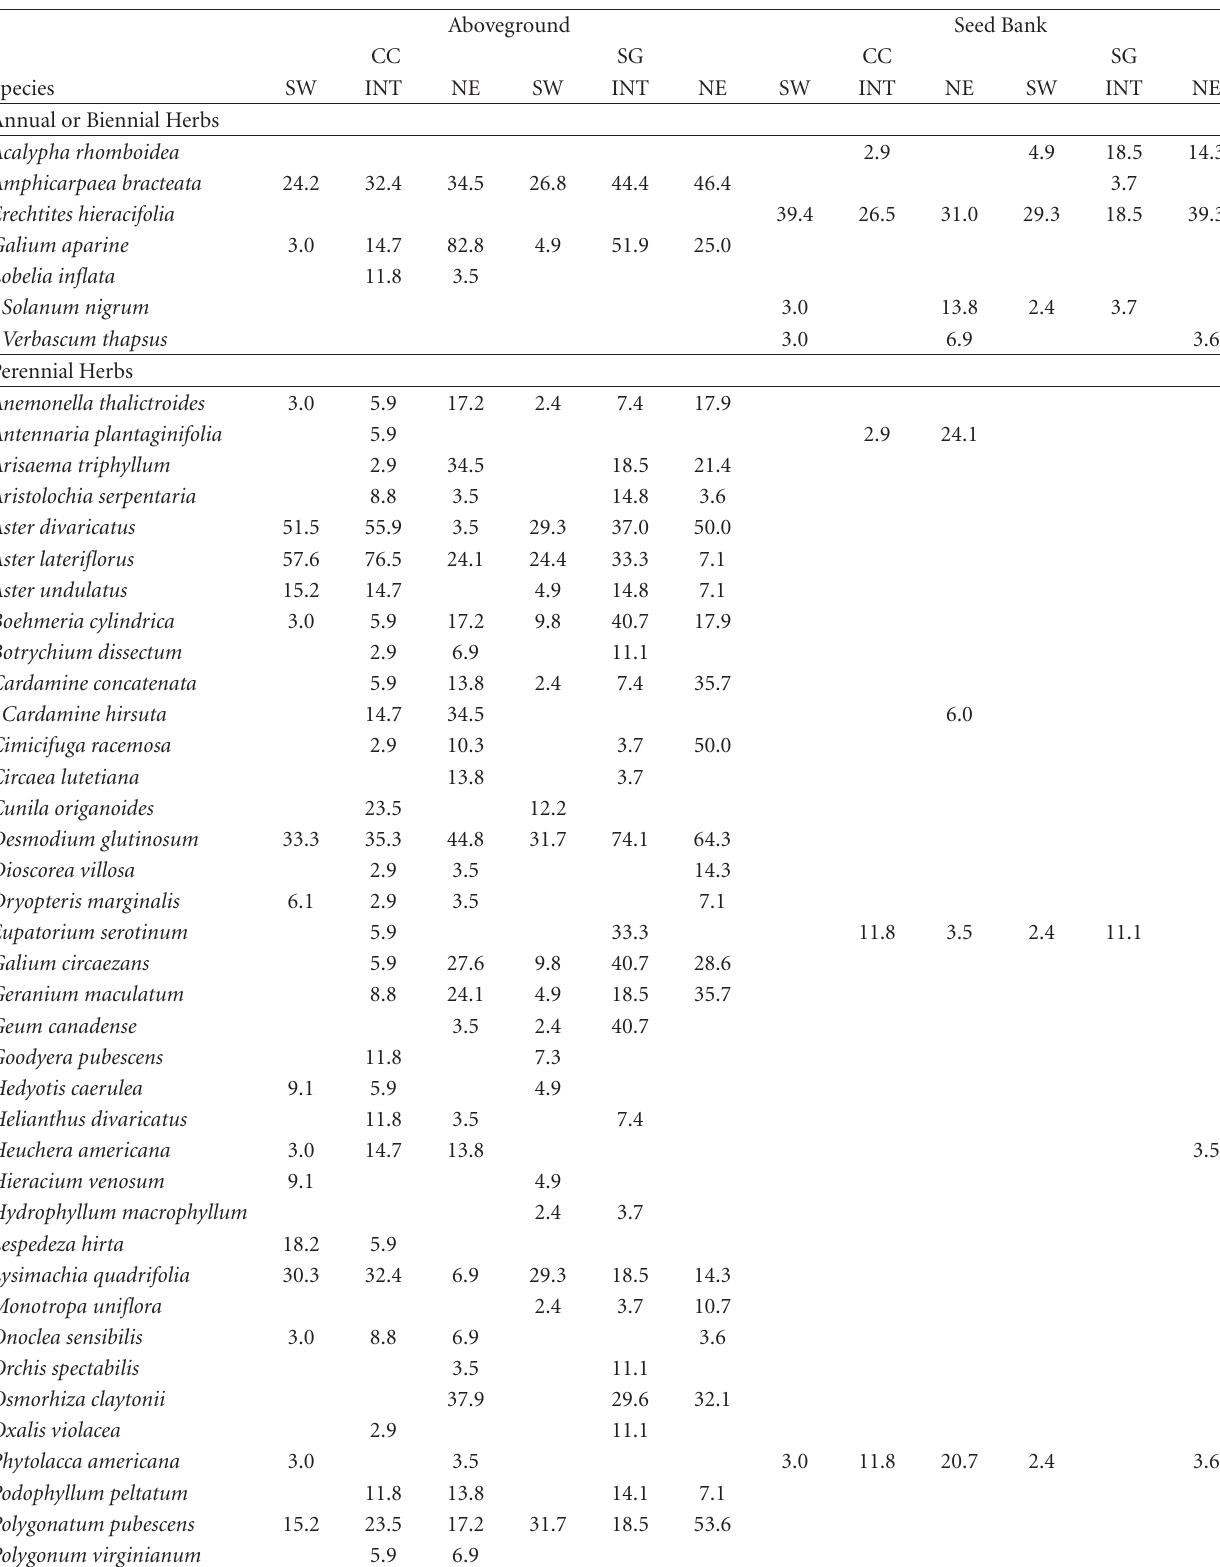
Table 3: Frequency of occurrence (% of samples) for aboveground understory (herbaceous and woody seedling) and seed bank species in revegetating clearcut (CC) and second-growth (SG) forest samples by aspect category at WWRS. Only species with frequencies > 12% across all stand/aspect categories are shown. Asterisk ( ∗ ) indicates a nonnative